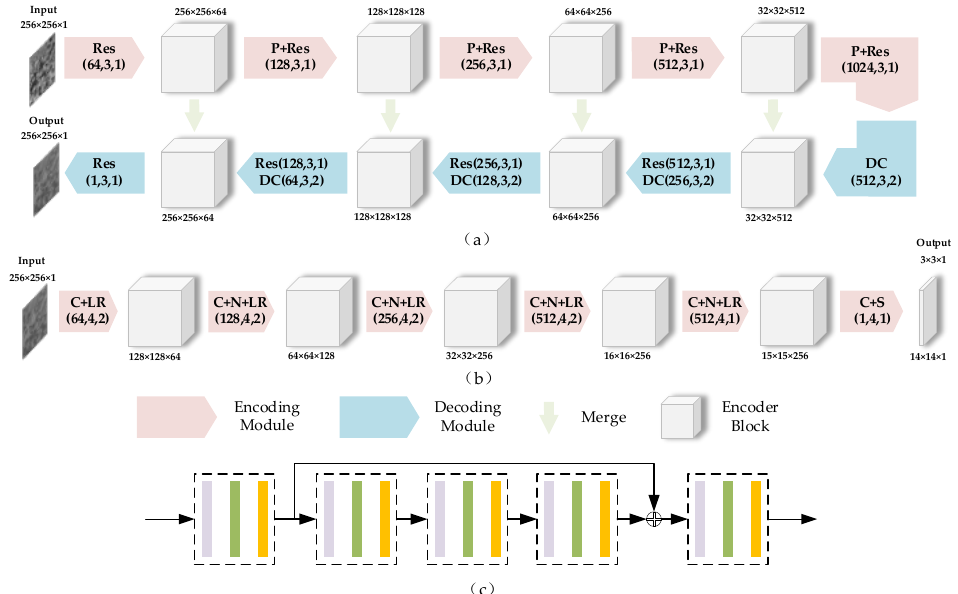
Figure 5. Architecture of the Despeckling GAN. ( a ) Generator (top). ( b ) Discriminator (bottom). ( c ) The detail of the Res. (The purple, green, and orange blocks in the dotted box correspond to the convolutional layer, the batch normalization layer, and the ReLU or Leaky ReLU layer, respectively). The numbers in brackets refer to the number of filters, filter size, and stride, respectively. The numbers above or below the encoder blocks and images indicate the input and output size of each module. Acronyms in the encoding and decoding modules are as follows: Res: Residual block with three convolutional layers and one skip connection, P: Maxpooling, DC: Deconvolution, C: Convolution, N: Batch Normalization, LR: Leaky ReLU, S: Sigmoid, Merge: Sum to average.